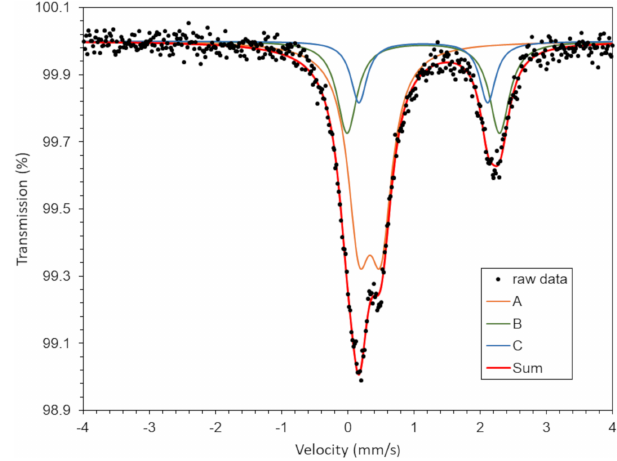
Figure 5. Mössbauer ( 57 Fe) spectrum of zinkgruvanite. See text for assignment of the three subspectra A, B and